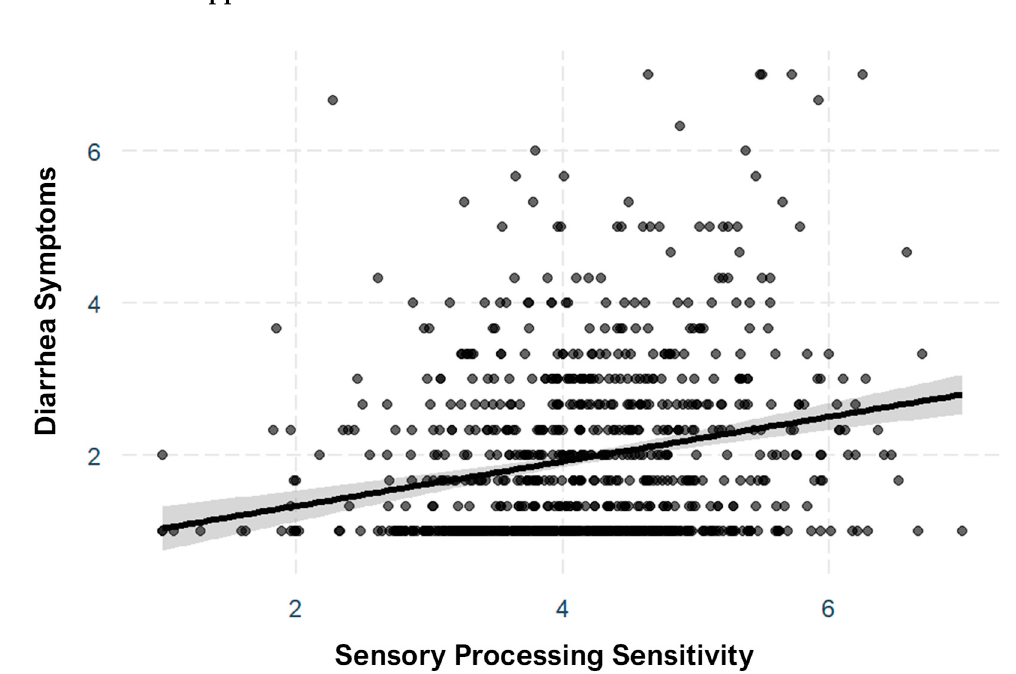
Figure A4. A Plot of the Regression Line Showing the Relationship between the Diarrhea Symptoms and Sensory Processing Sensitivity.